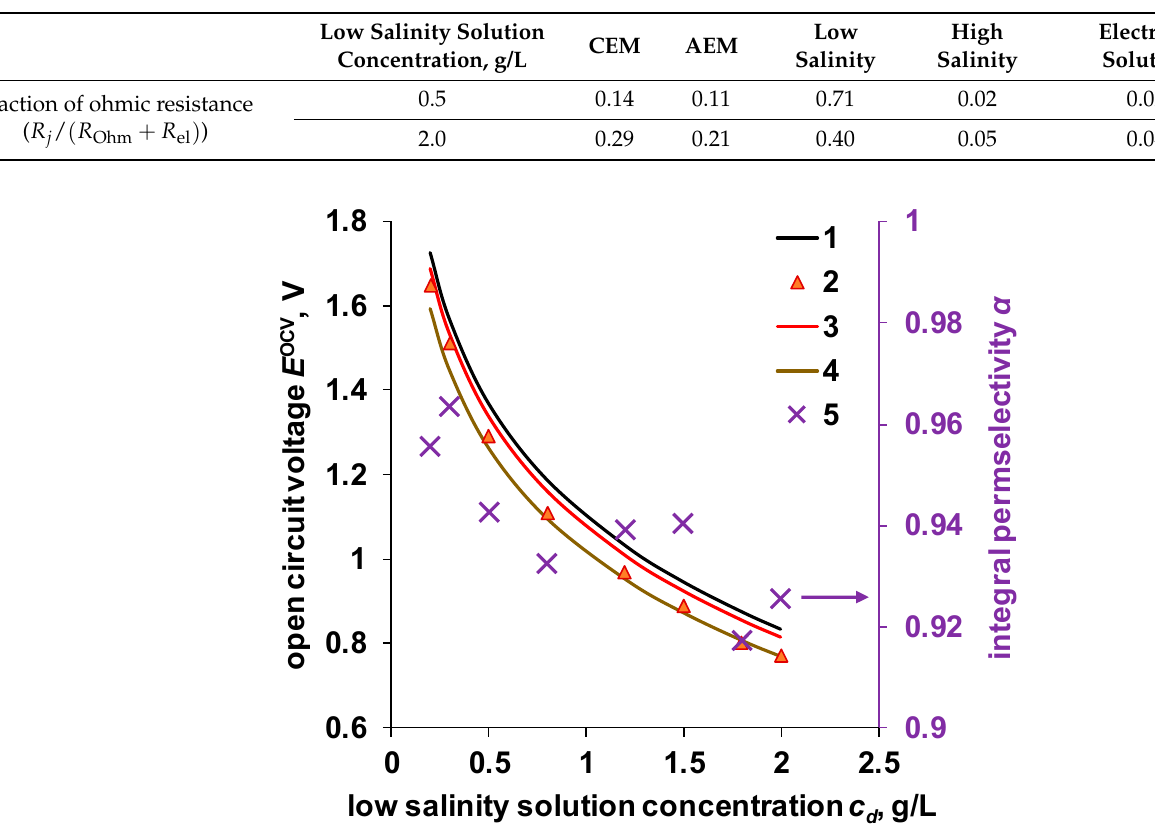
Figure 9. Dependence of the OCV on the RED module on low salinity solution concentration. 1—theoretical value calculated using Equation (1) with α = 1, 2—experimental OCV value for Ralex membrane pair, 3 and 4—theoretical value calculated for Ralex and MK-40/MA-41 membrane pairs using Equations (2) and (5), 5—integral permselectivity for Ralex membrane